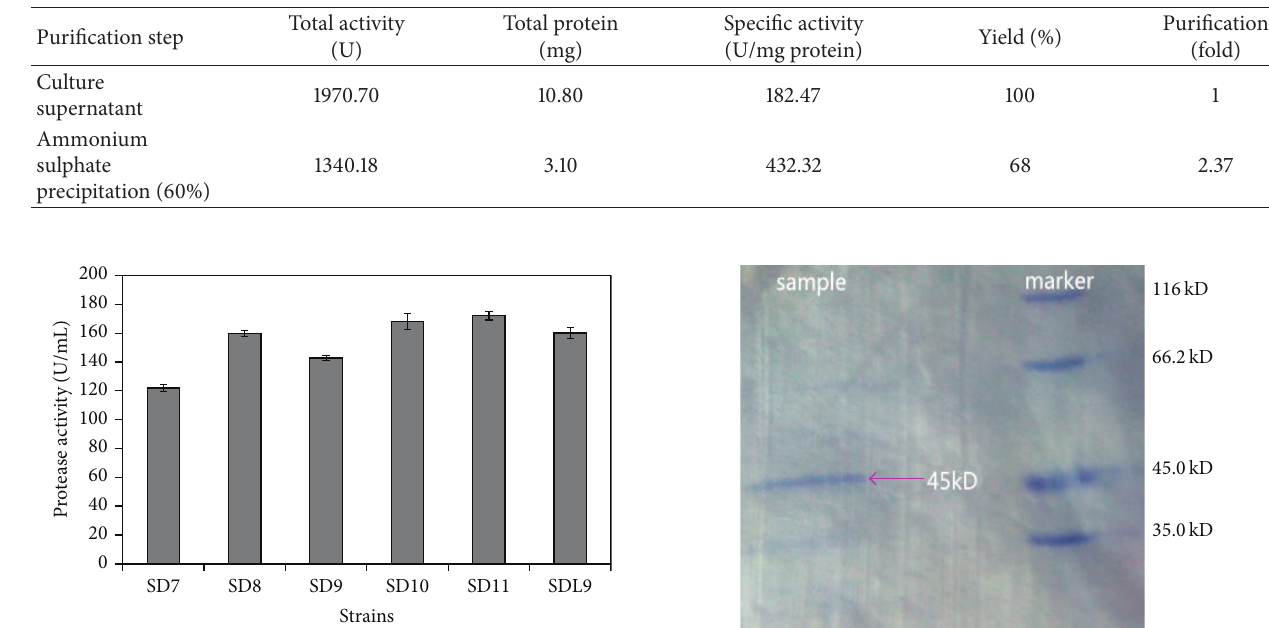
Table 2: Purification of protease from strain SD11.